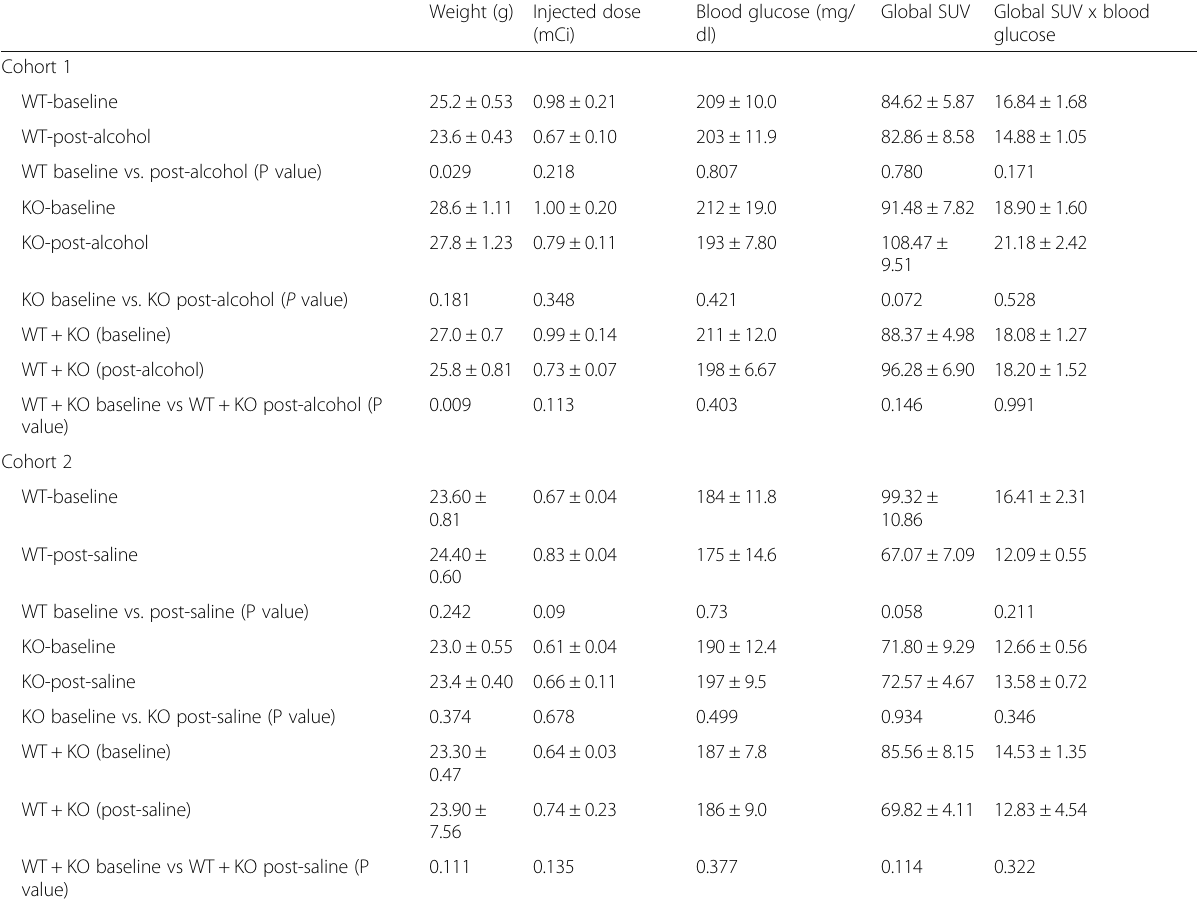
Table 6 Absolute SUV values corrected for plasma glucose concentration. Global SUV values corrected for glucose levels at post- alcohol between WT and CIRP − / − mice are significant ( P = 0.034, unpaired t-test). No group differences were seen in global SUV values in percent changes between pre- and post-saline treatment ( P > 0.07, unpaired